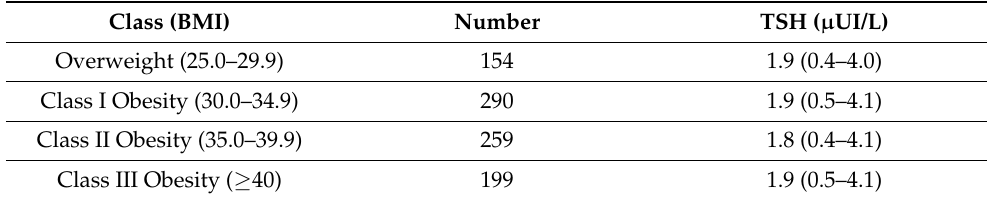
Table 1. Median values and range of TSH serum concentrations by BMI class.